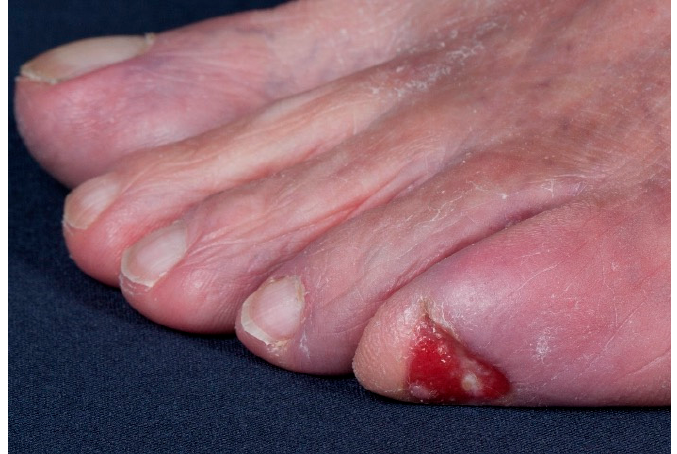
Figure 4. Example of an SCC on the toe, presenting as a chronic ulcer of an unknown etiology.